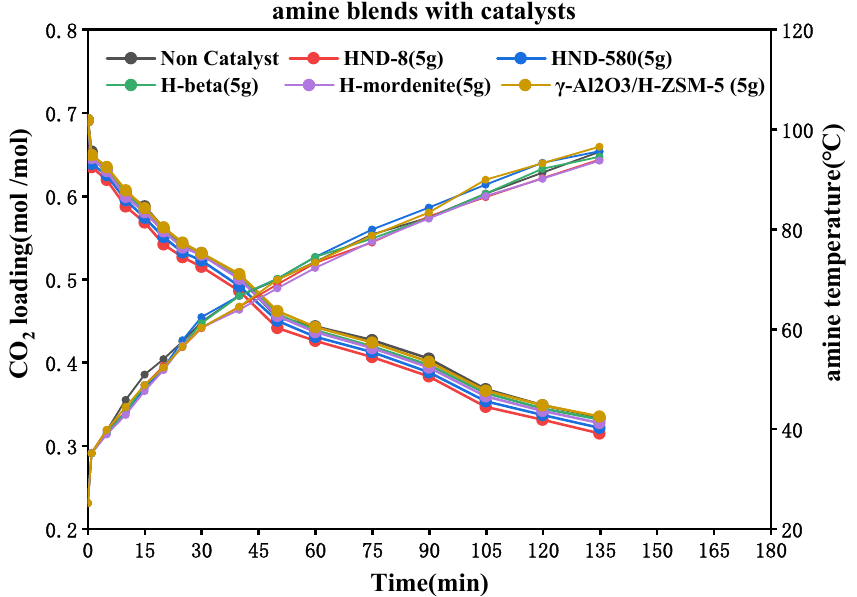
Figure 7. The CO 2 desorption profiles of MEA + EAE + AMP at 0.3 + 1.5 + 2.5 mol/L with catalysts of 0.3 + 1.5 + 2.5 mol/L.